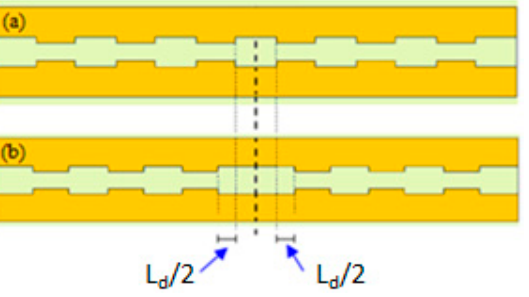
Figure 7. Top view of ( a ) the Bragg grating and ( b ) the plasmonic cavity with the defect to create the resonant behaviour.